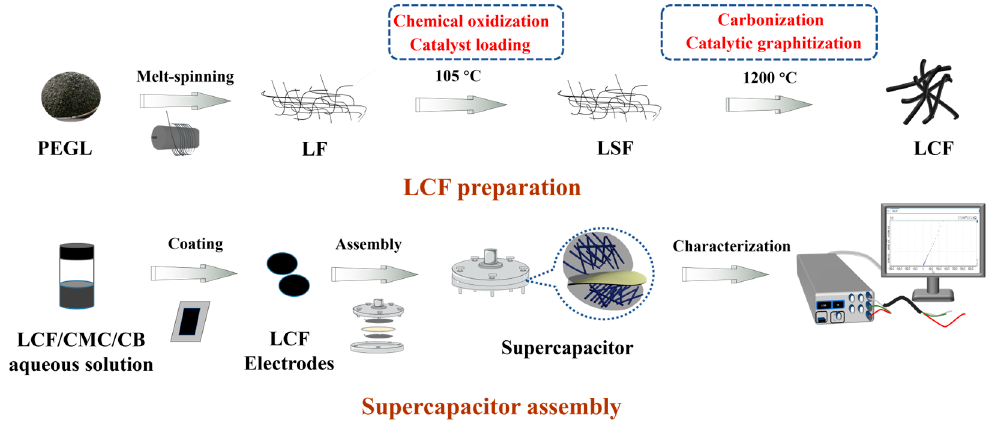
Figure 1. Schematic illustration of LCF preparation and supercapacitor assembly .